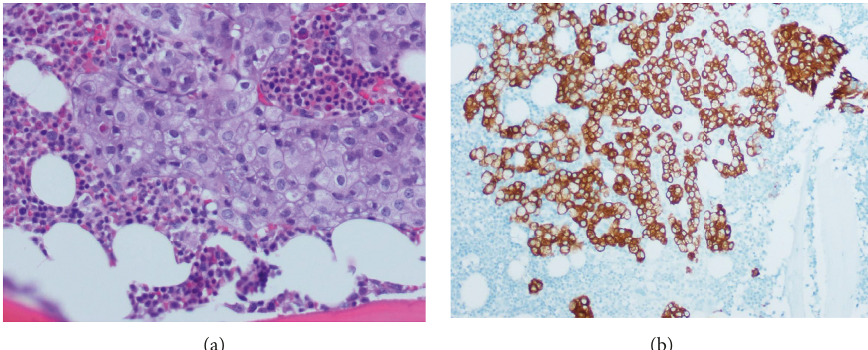
Figure 1: Groin skin. (a) Hematoxylin and eosin: within the dermis, there are clusters of large tumor cells with pleomorphic nuclei. (b) Cytokeratin stain highlights the tumor cells.